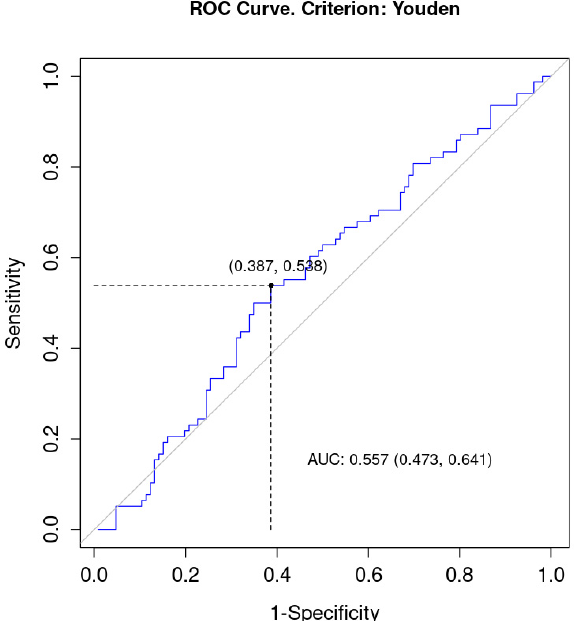
Figure 5. ROC (Receiver Operating Characteristic) curve for NLR as a discriminator of EMVI. AUC, area under curve.